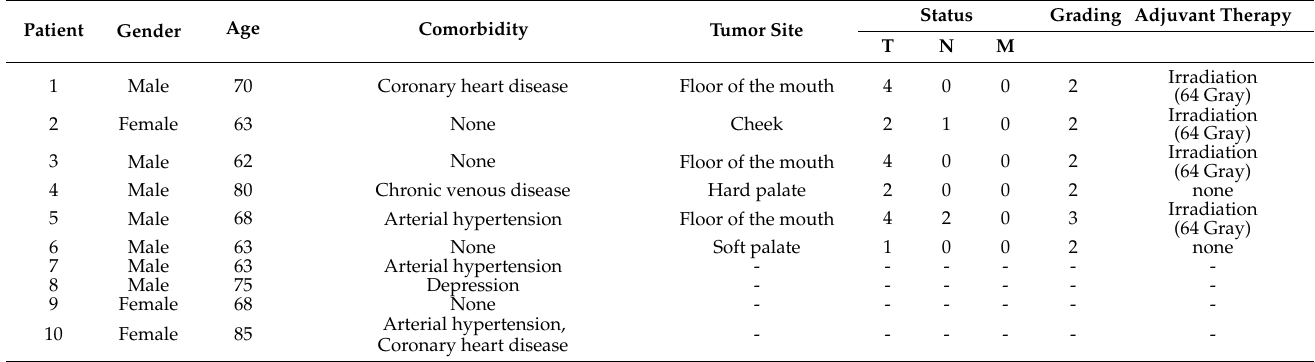
Table 1. Characterization of OSCC and age-matched healthy control